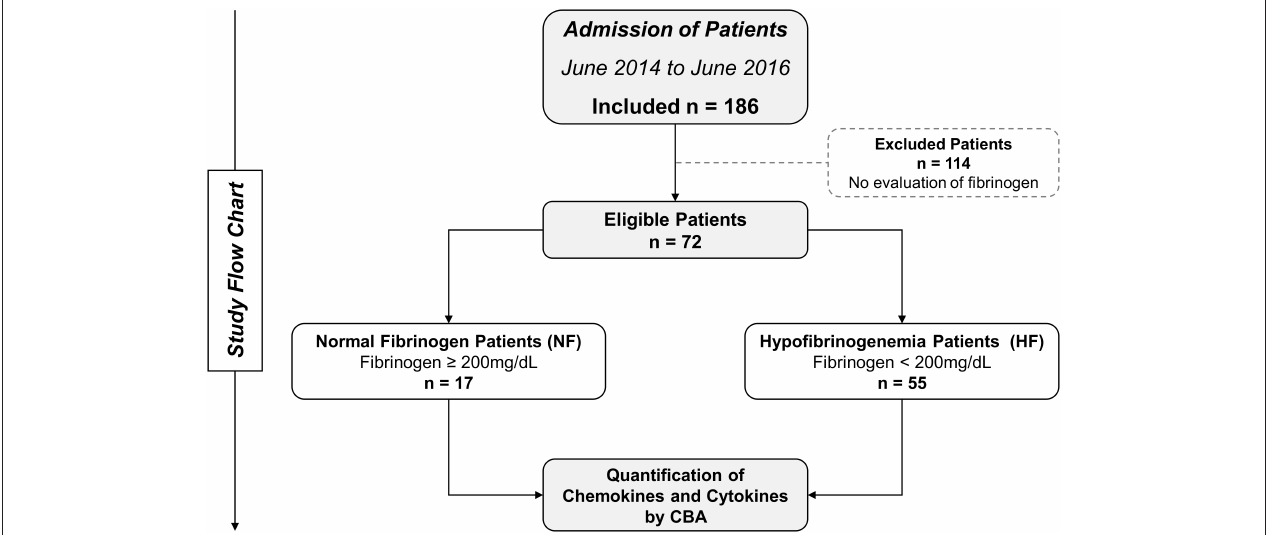
FIGURE 1 | Flowchart of study. Seventy-two patients were eligible and followed up until discharge. These patients were divided into two groups: normal fibrinogen (NF) and hypofibrinogenemia (HF), according to their fibrinogen consumption.